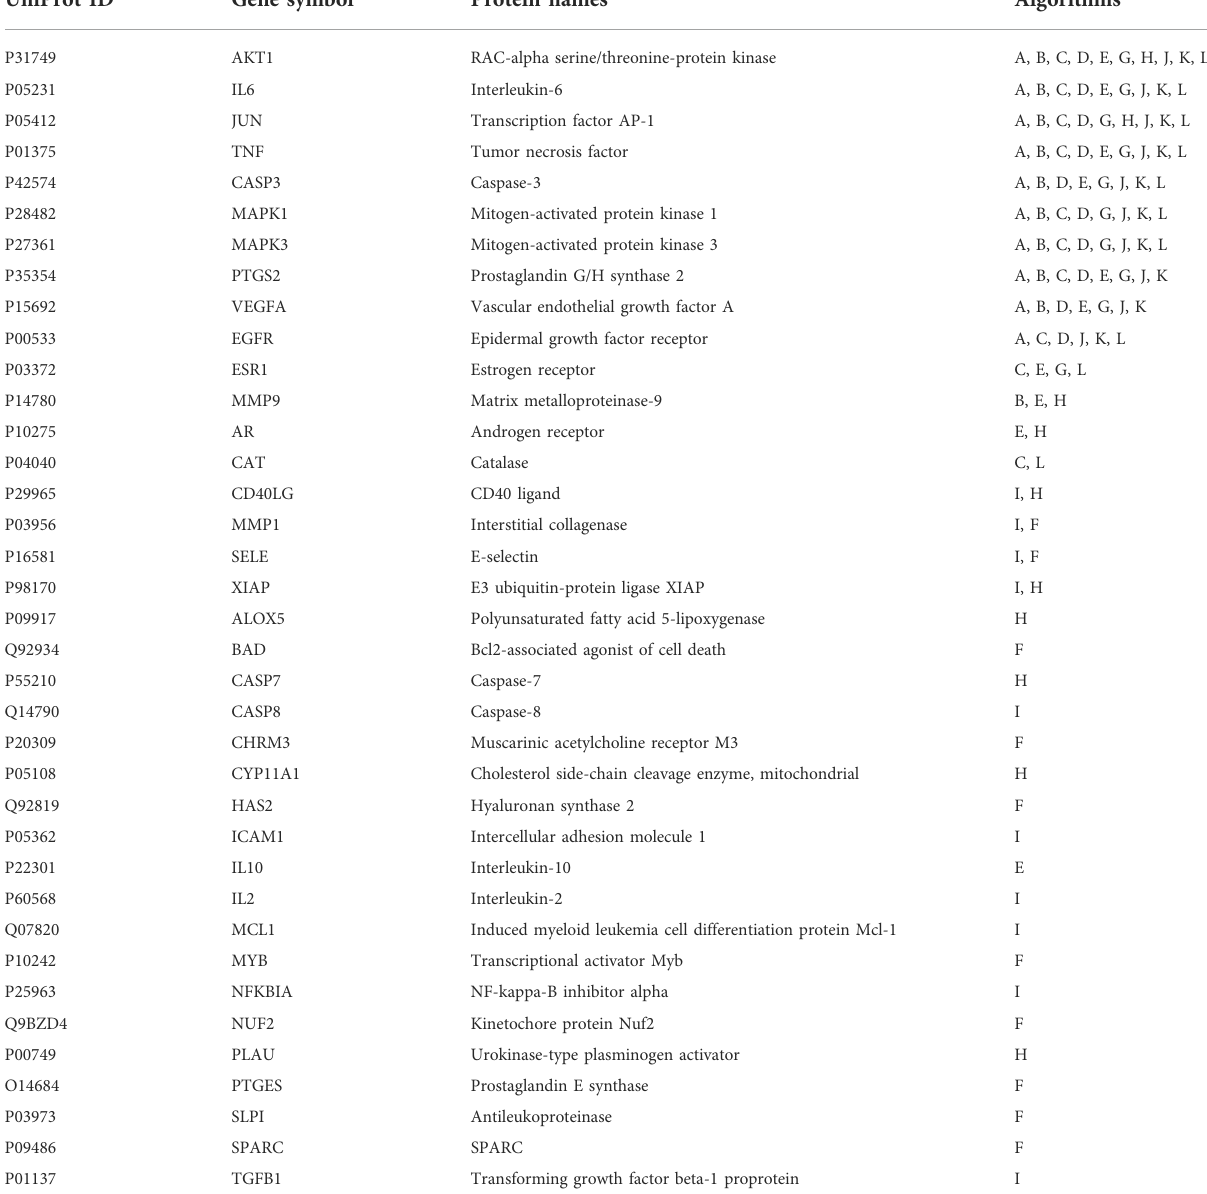
TABLE 2 Basic information of top 10 hub genes by 12 CytoHubba algorithms. UniProt